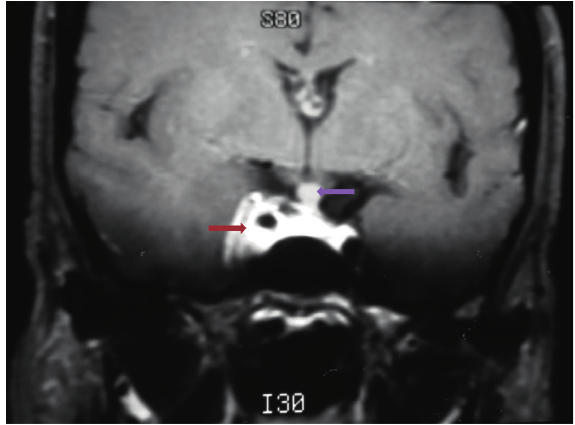
Figure 2: Coronal sequence, after contrast, in T1, showing ex- pansive, extra-axial, parasellar lesion, with intense enhancement after contrast infusion, involving the right cavernous sinus and the carotid, without compromising their diameters (red arrow); thickening of the pituitary stem of an indeterminate nature (purple